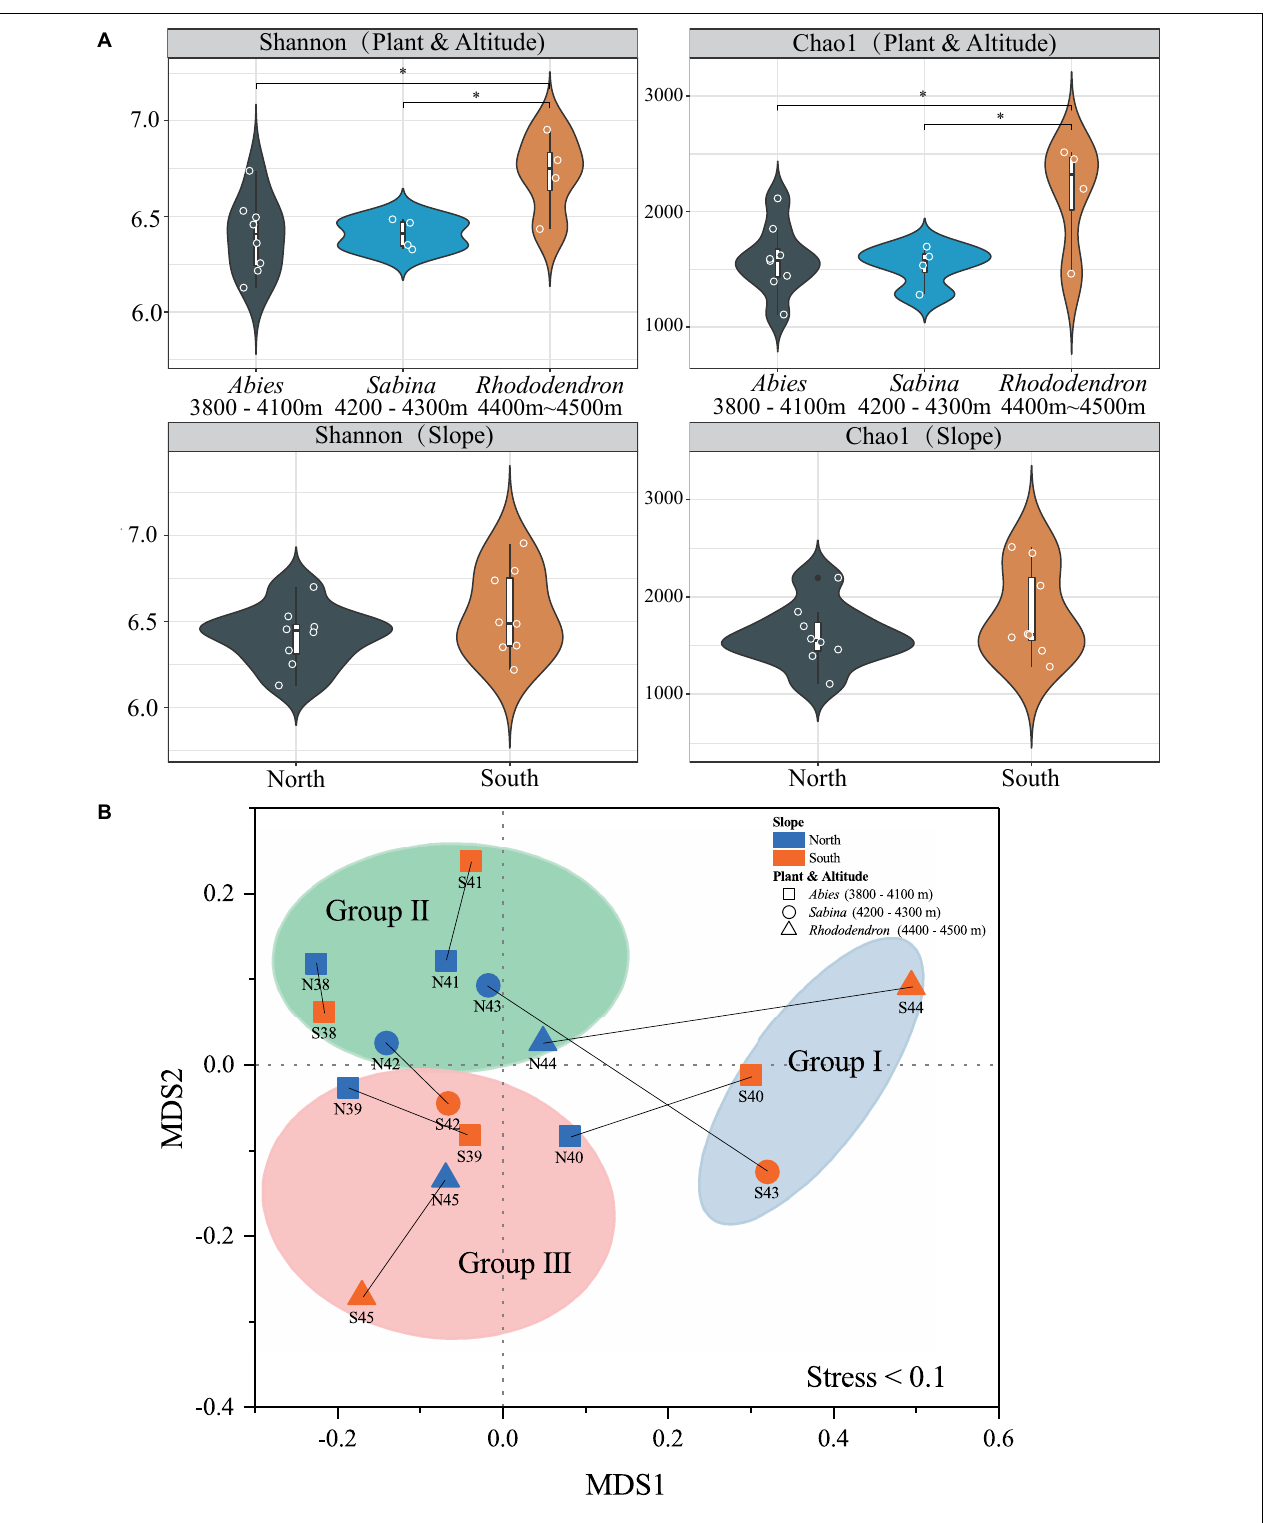
FIGURE 2 | Alpha diversity (A) and beta diversity (B) of bacterial communities in the soils of Mt. Shergyla were classified by slope aspects or aboveground vegetation. The “*” symbol in (A) represents a significant difference ( p < 0.05) between the two groups connected by the line below. The non-metric multidimensional scaling (NMDS) results in this study were acceptable because the stress value (0.1) was lower than 0.2 (Clarke, 1993). The blue and red colors indicate soil samples that were collected from the north and south slopes, respectively. The shaped symbols represent the overlying plant species of the soil samples. The colored shadow represents different groups of soil samples categorized by the aforementioned hierarchical clustering analysis